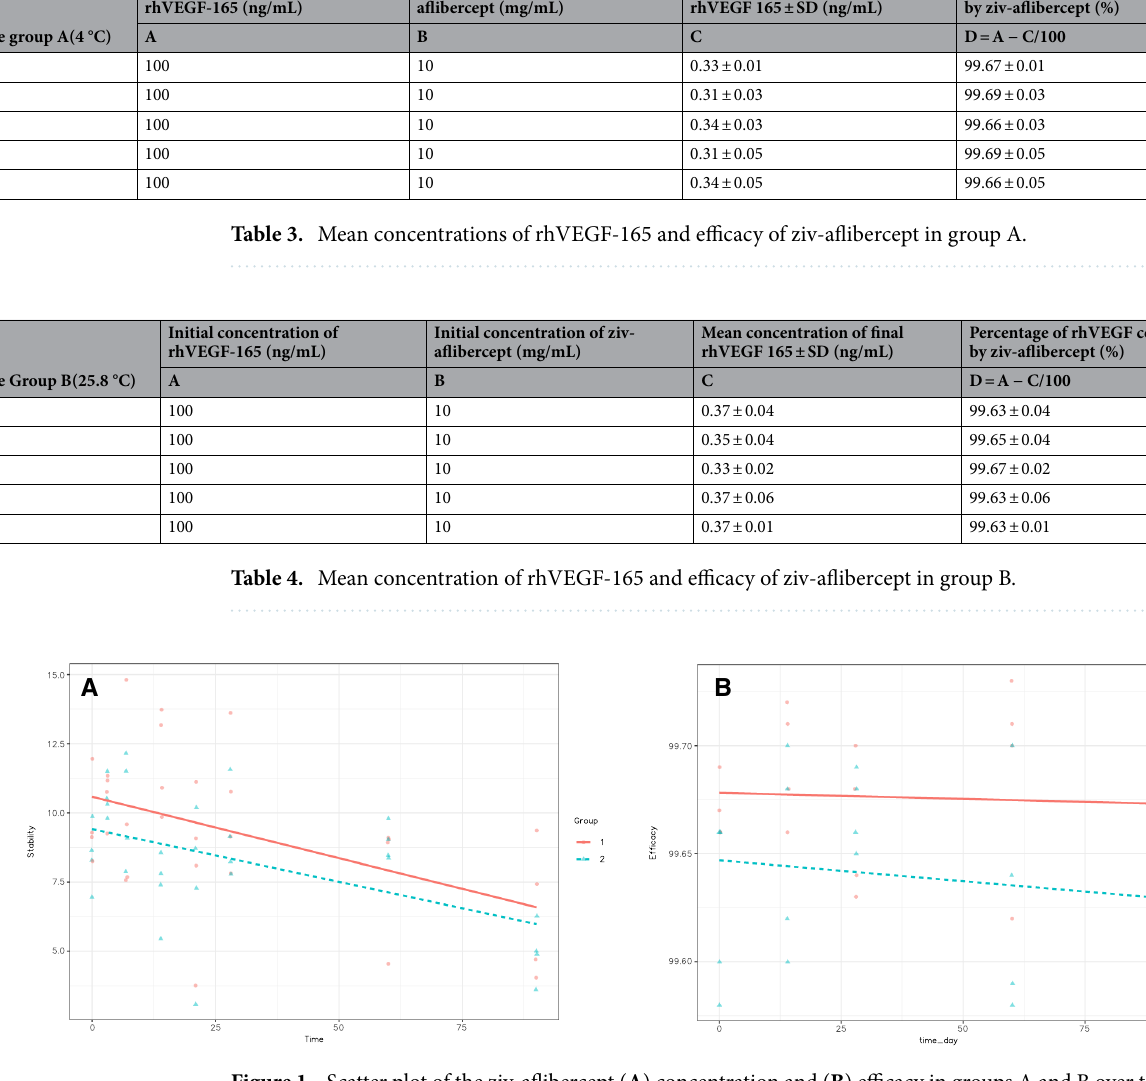
Figure 1. Scatter plot of the ziv-aflibercept ( A ) concentration and ( B ) efficacy in groups A and B over